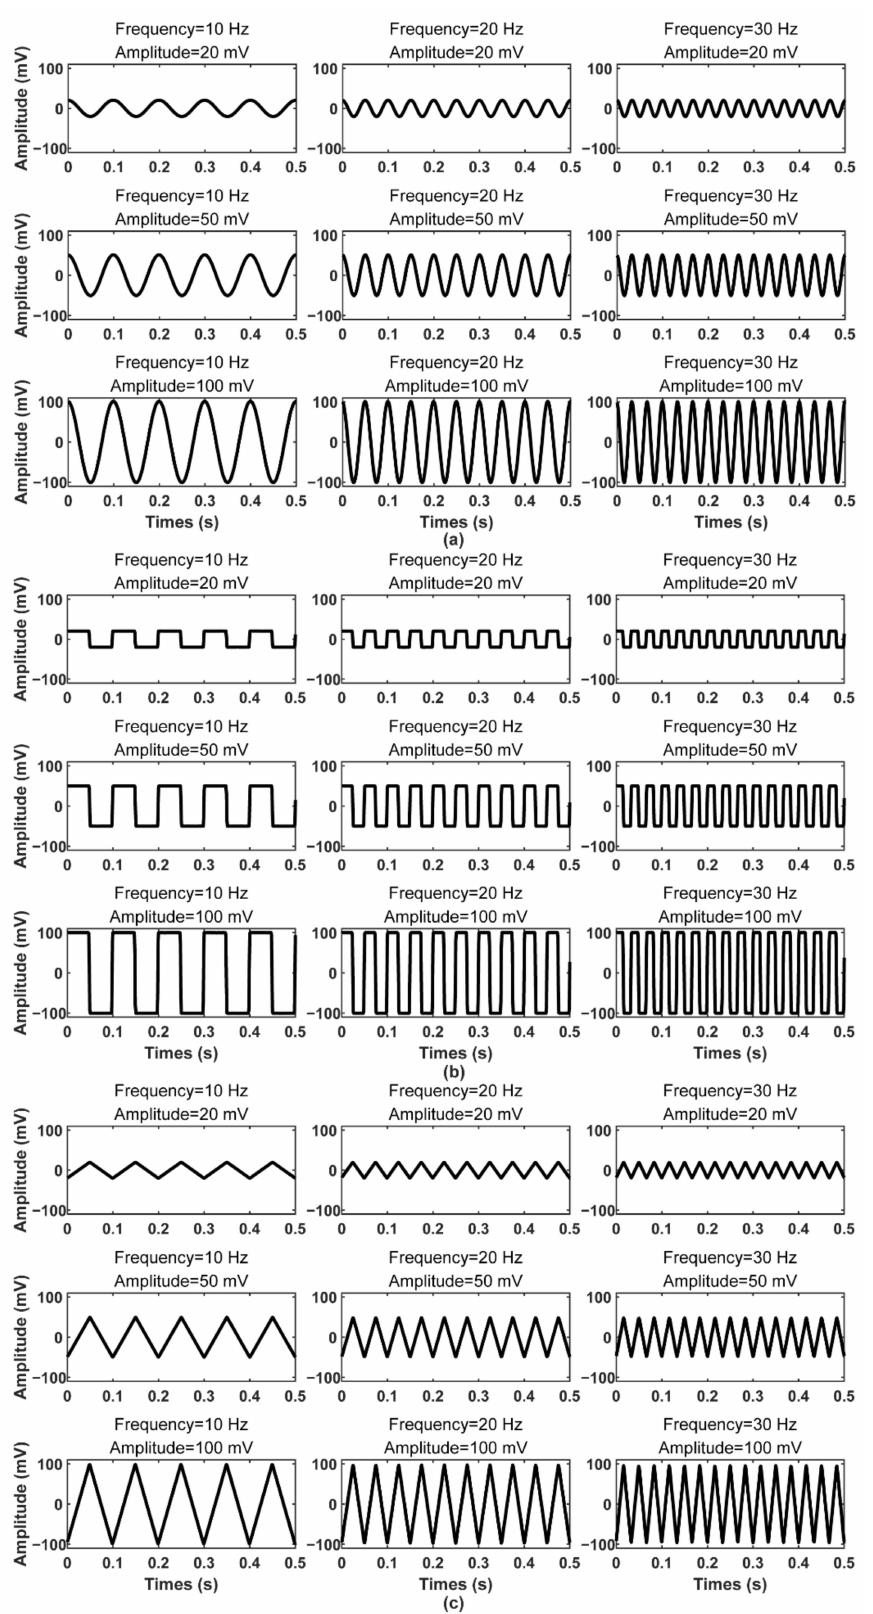
Figure 4. Simulated signals recorded by Mindeep. ( a ) Sine wave; ( b ) square wave; and ( c ) triangular wave with different frequencies (10 Hz, 20 Hz, and 30 Hz) and amplitudes (20 mV, 50 mV, and 100